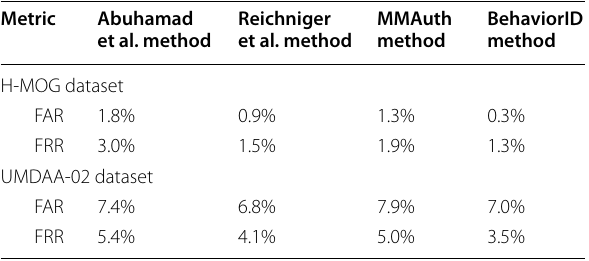
Table 5 Estimated values of FAR and FRR during multifactor authentication in various usage contexts